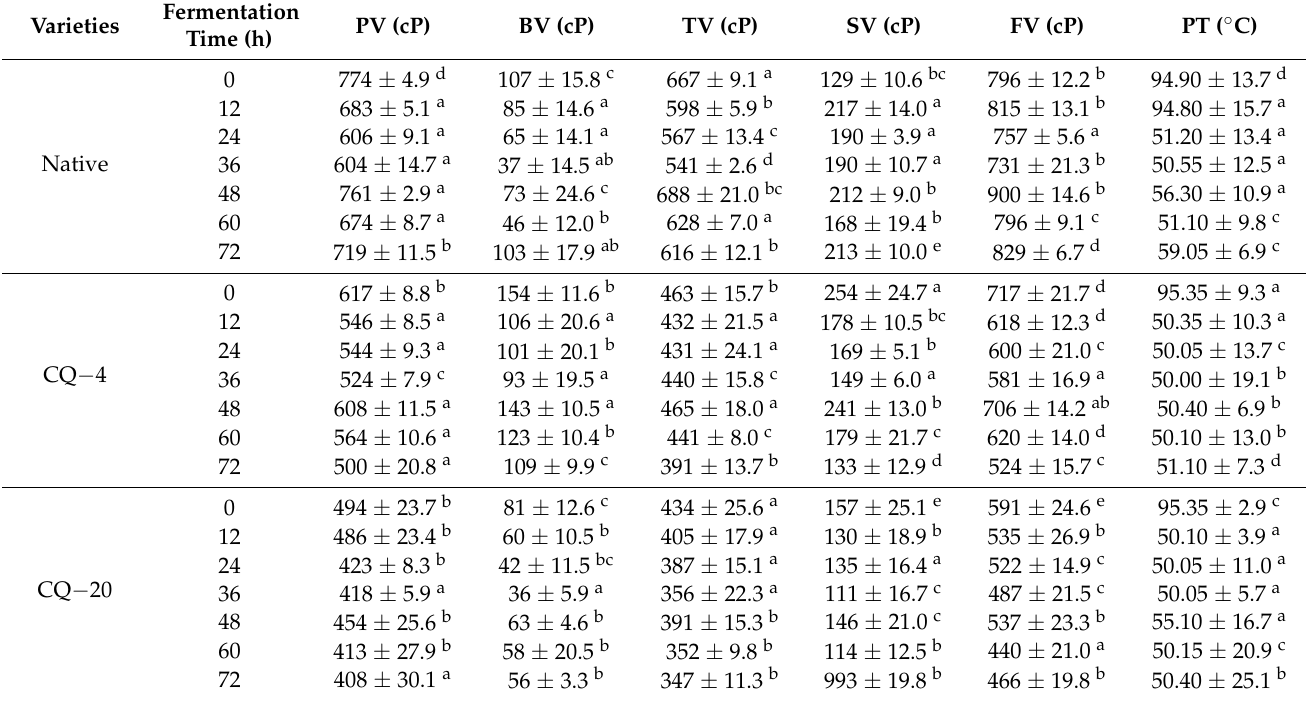
Table 3. Pasting properties of native and fermented quinoa under 4 ◦ C and − 20 ◦ C cold stress